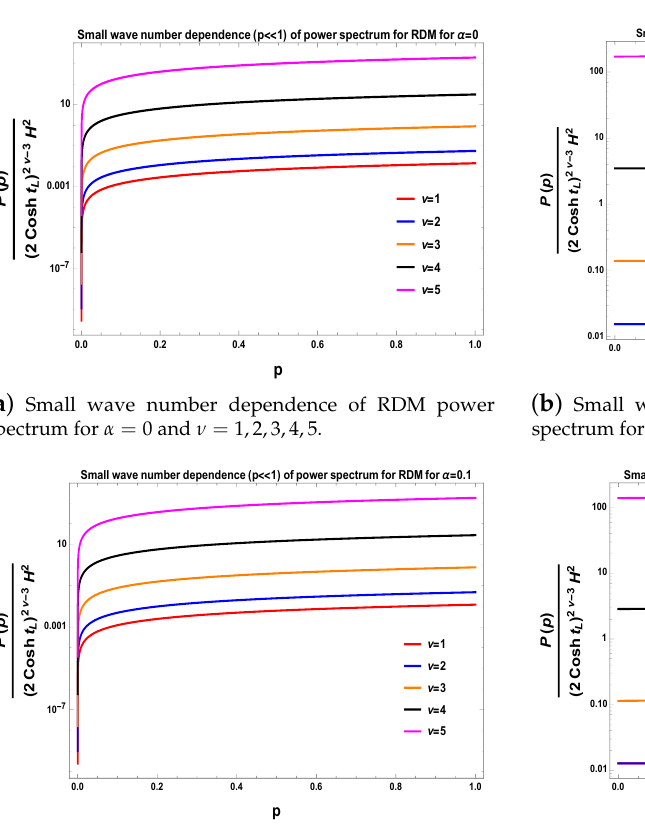
( d ) Small wave number dependence of RDM power spectrum for α = 0.1 and ν = 1/2,3/2,5/2,7/2,9/2.